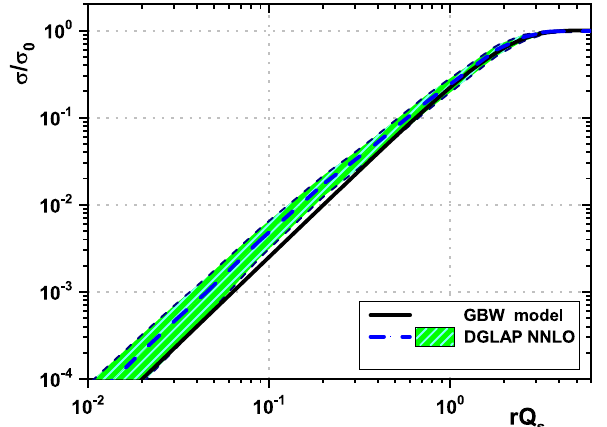
Fig. 8 The extracted ratio σ dip ( rQ s ( x ))/σ 0 as a function rQ s for x = 10 − 4 within the NNLO approximation (dashed curves), accompanied with the statistical errors in the parametrization of F 2 and its derivative, compared with the GBW model (solid curve)